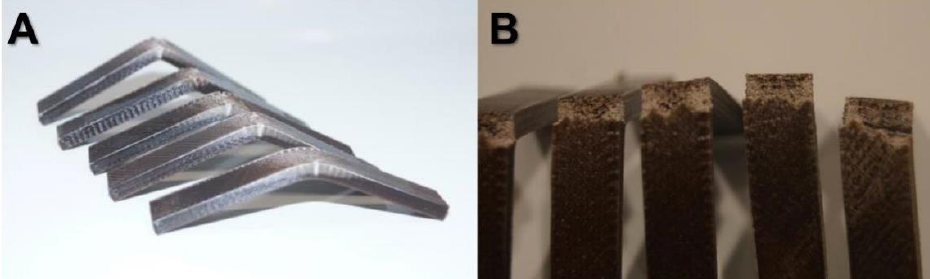
Figure 4. The standard bending specimen of PLA/coffee grounds after the bending test: ( A ) PLA/3% coffee grounds composite 3D printing products; ( B ) PLA/7% coffee grounds composite 3D printing products.